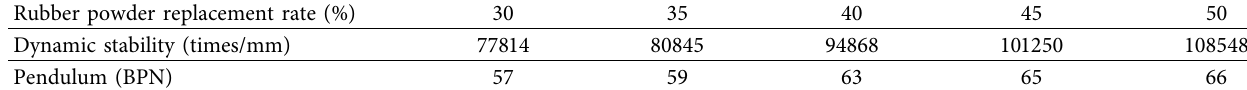
Table 5: High-temperature and antiskid performance of ultrathin overlay epoxy-rubber concrete.